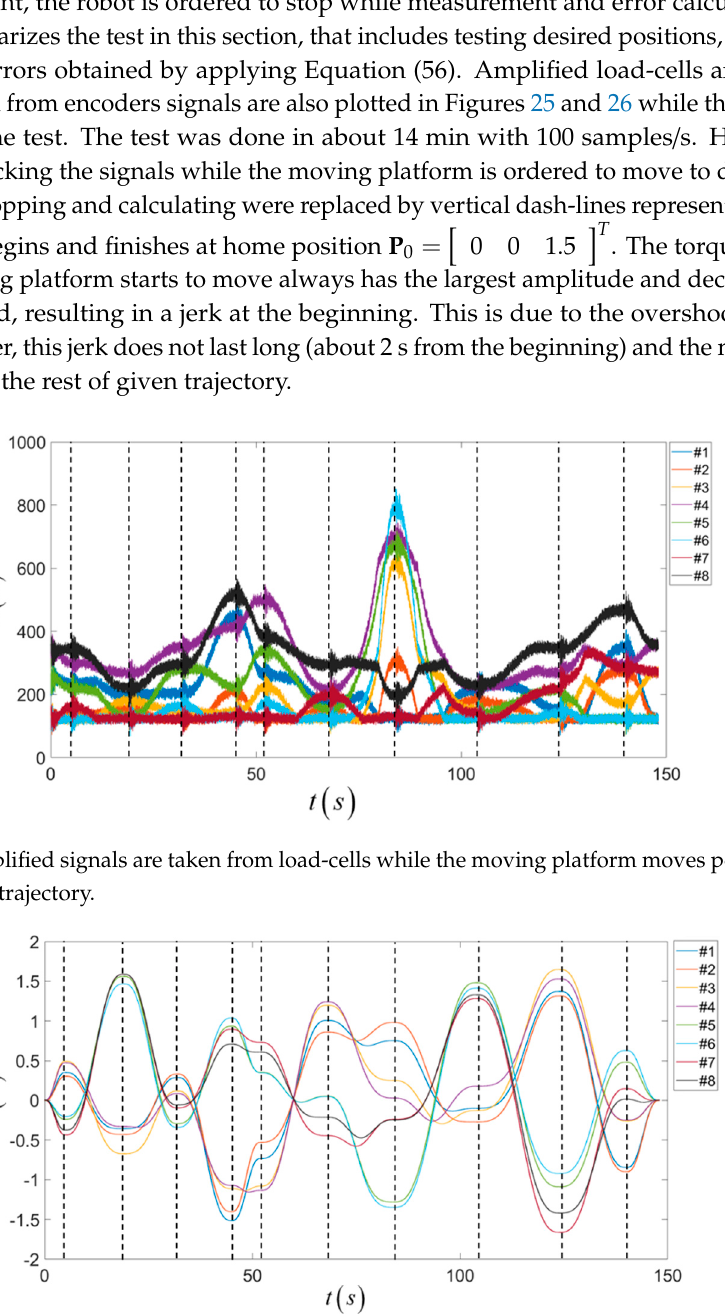
Figure 26. Different cable lengths are obtained by integrating the encoder signal while the moving platform moves point-to-point with the linear trajectory.